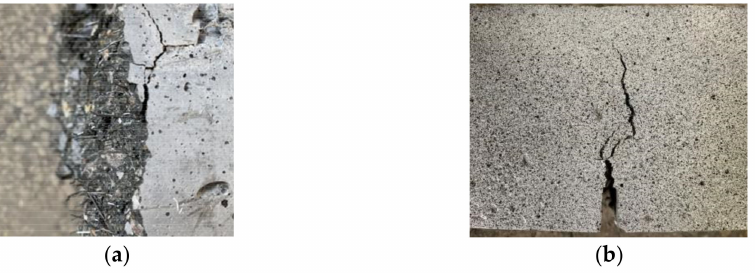
Figure 7. Steel fiber distribution in cross section and crack development of notch. ( a ) Steel fiber distribution in the cross section; ( b ) Crack development of